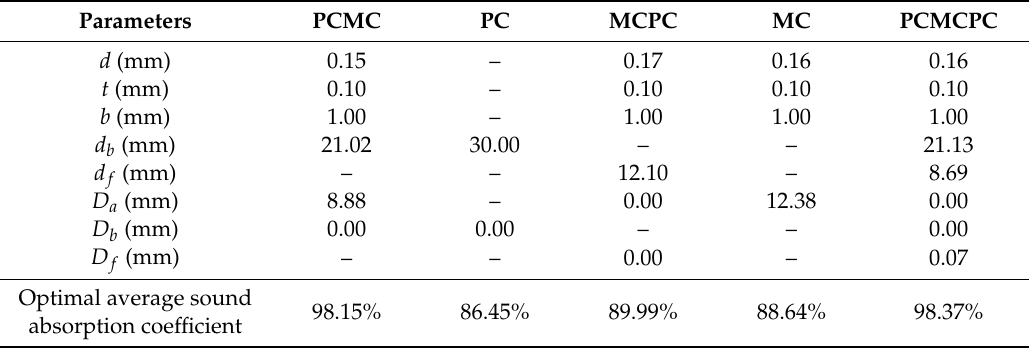
Table 3. Summarized optimal parameter of composite structure with limited total thickness 30